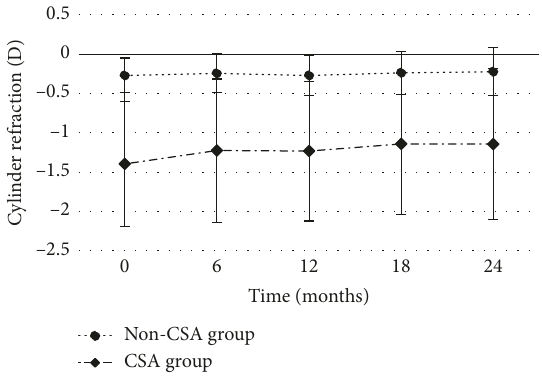
Figure 1: CSA and non-CSA changes in cylinder refraction.